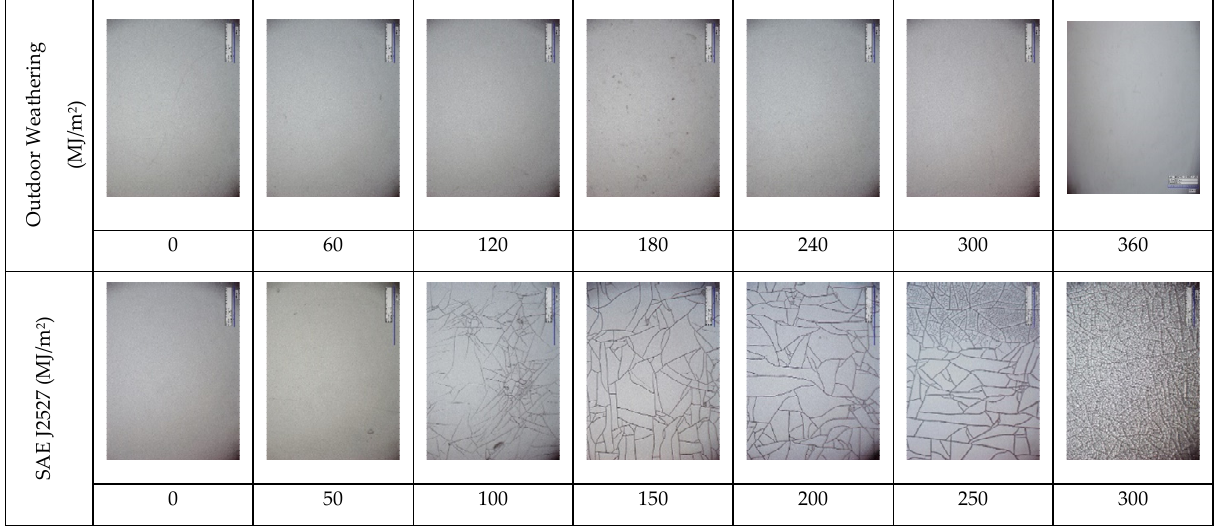
Figure 22. Microscopic images (×350) of weather-exposed surfaces of polycarbonate between natural outdoor weathering at Seosan and accelerated weathering test per SAE J2527. Table 7. Accelerated weathering test